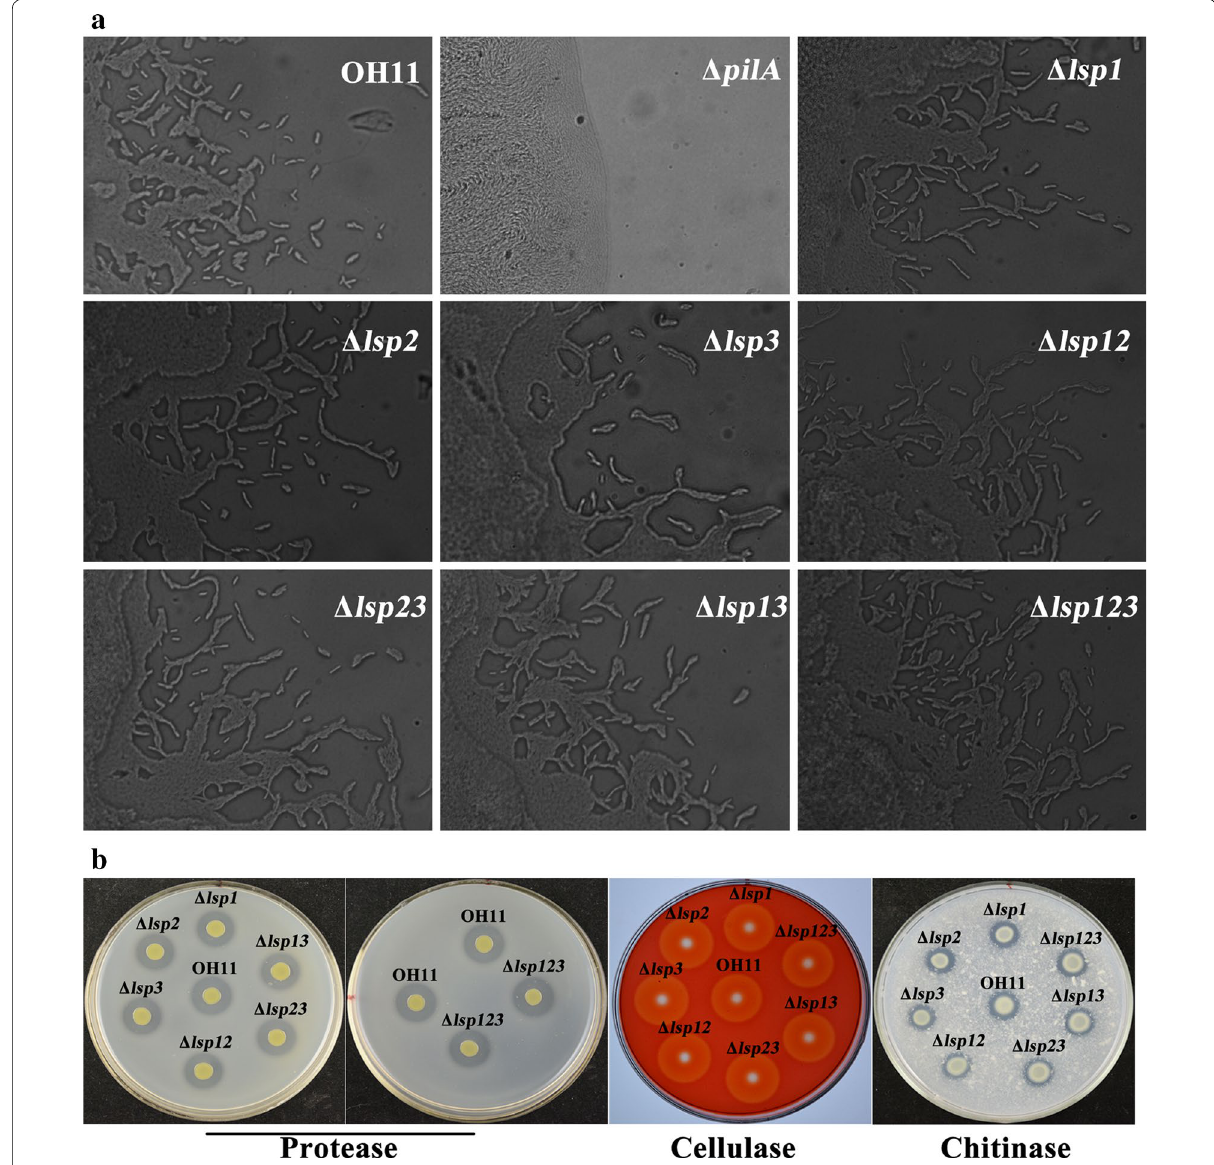
Fig. 2 Deletion of Lsp protein genes individually or in various combinations in Lysobacter enzymogenes did not disrupt twitching motility ( a ) and production of extracellular protease, cellulase and chitinase ( b ). In a , individual cells or cell clusters produced at the margin of colony are character- istic of twitching motility in L. enzymogenes . OH11: wild-type strain of L. enzymogenes ; Δ pilA : twitching-motility deficient mutant used as a negative control; Δ lsp1 , Δ lsp2 and Δ lsp3 : mutants with in-frame deletions lsp1 , lsp2 and lsp3 , respectively; Δ lsp12 , Δ lsp13 and Δ lsp23 : double in-frame deletion mutants with double deletions at lsp1 and lsp2 , lsp1 and lsp3 , and lsp2 and lsp3 , respectively; Δ lsp123 : the triple deletion mutant lacking lsp1 , lsp2 and